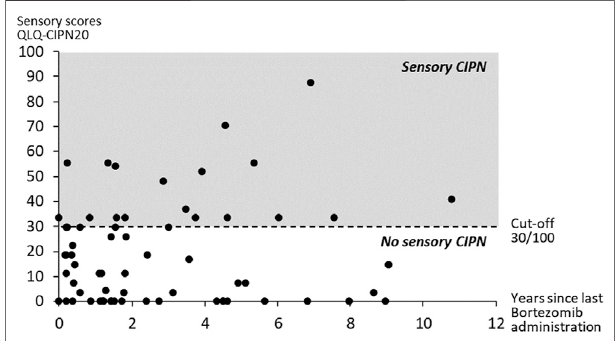
FIGURE 2 | Distribution of the sensory scores of the QLQ-CIPN20 for each patient and over years after the end of bortezomib administration.